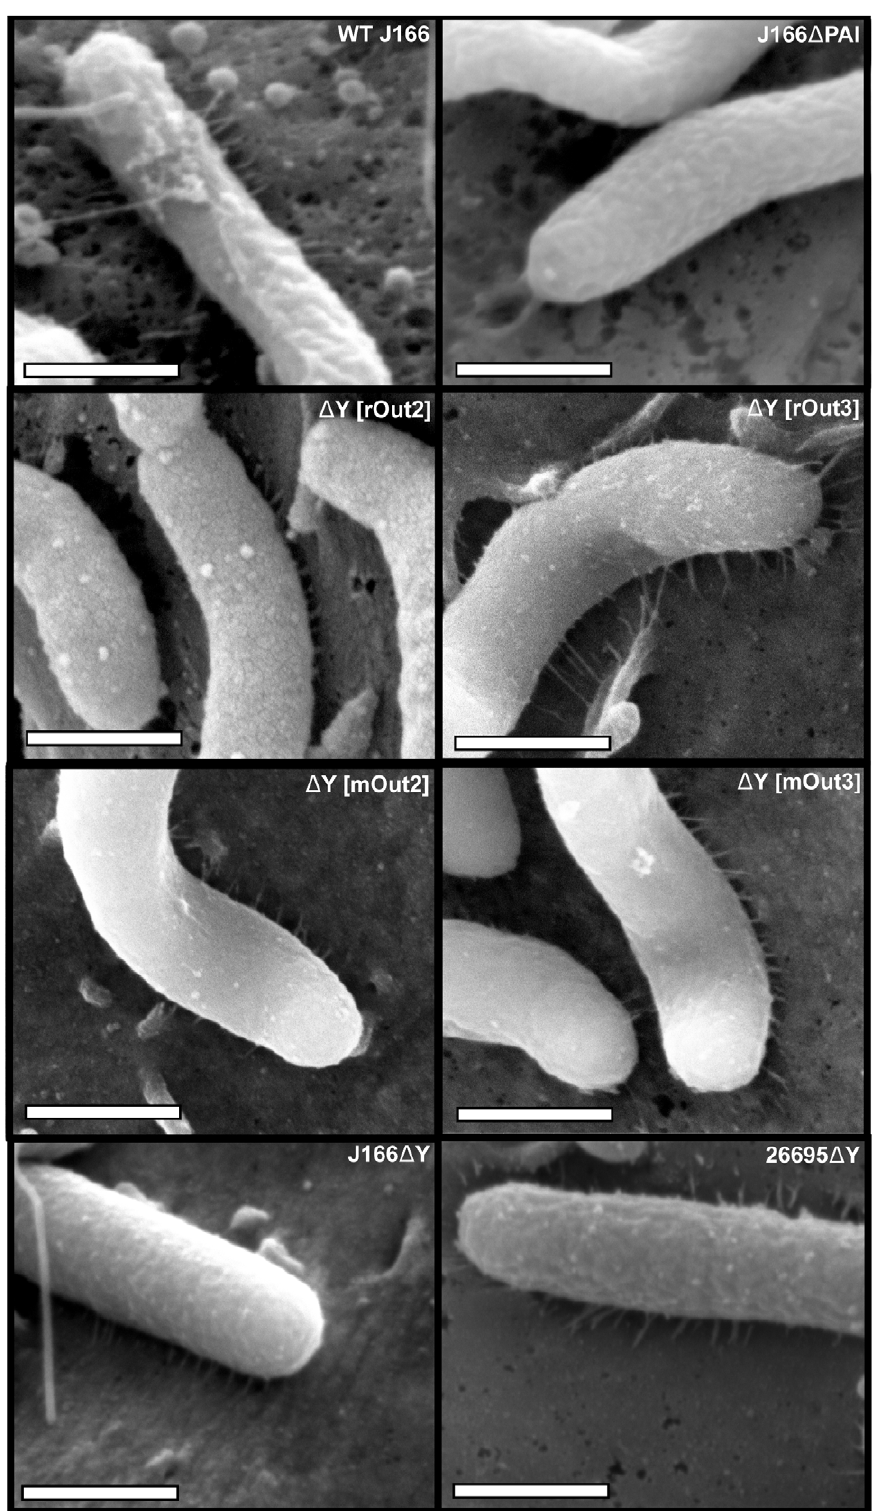
Figure 7. Changes in the motif structure of the CagY middle repeat region that alter the function of the cag PAI do not affect expression of T4SS pili on the bacterial surface. H. pylori was co-cultured with AGS gastric cells at an MOI of 100:1 and imaged by FEG-SEM. T4SS pilus structures were readily apparent in the WT H. pylori J166 but not in the cag PAI deletion mutant (J166 n cag PAI). T4SS pili were also observed in H. pylori J166 in which the WT cagY allele was replaced with that from output strains with a functional (rOut3, mOut3) or a non-functional (rOut2 mOut2) cag PAI. Pili were also seen in H. pylori strains J166 and 26695 with deletions in cagY . Magnification bars indicate 500 nm.